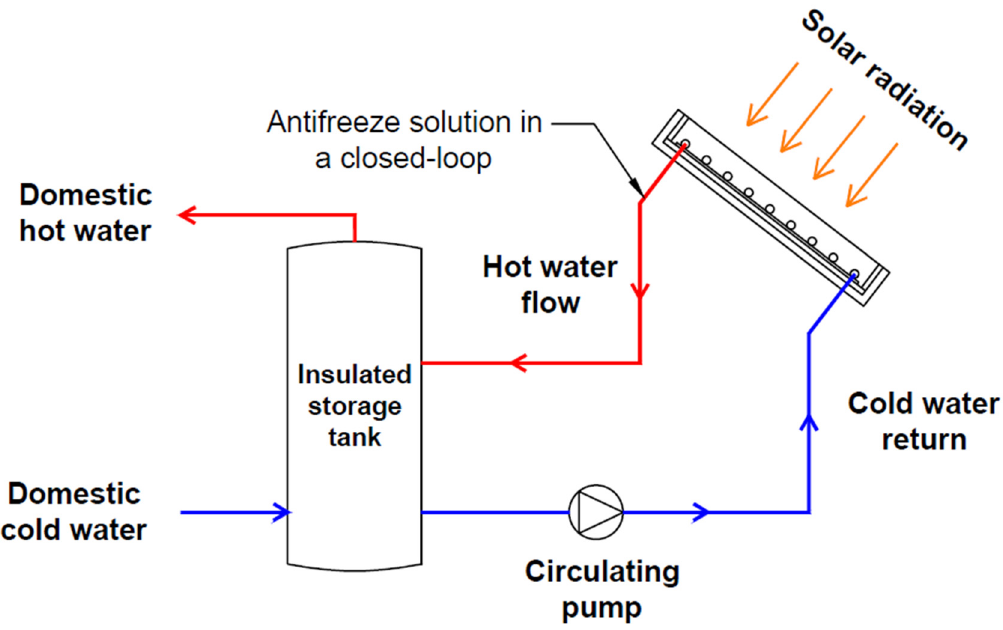
Figure 5. The working principle of an FPC solar water heater with an active, split system [56].